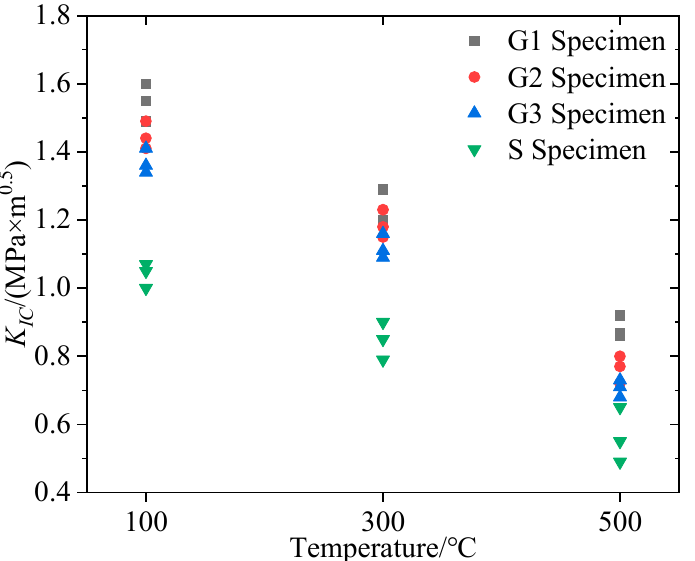
Figure 12. Variation of fracture toughness with specimen lithology and temperature.